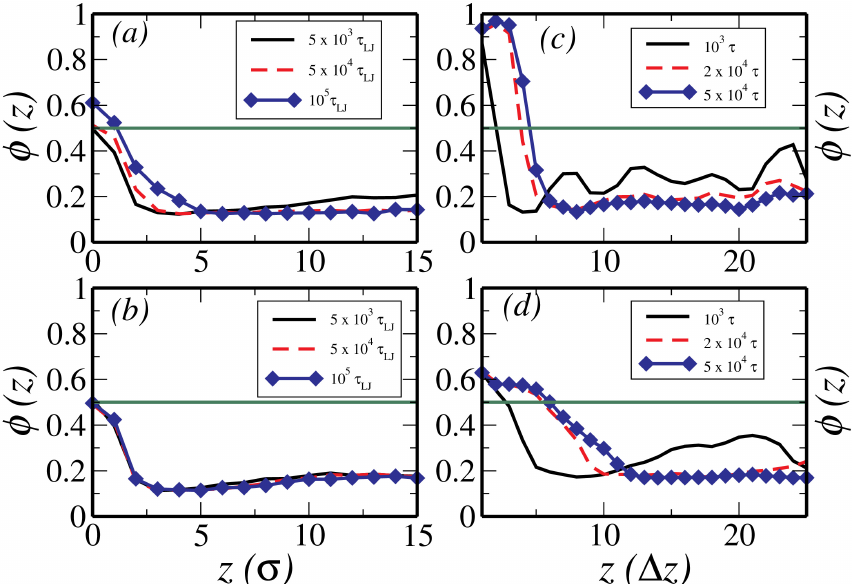
Figure 4. The time-evolution of the oligomer density computed from MD simulation in a polymer–oligomer system ( a ) and a gel–oligomer system ( b ) following a quench from an initial temperature of T i = 10 to a final temperature of T f = 1; ( c , d ) show the time evolution of the oligomer density computed from meso-scale simulations, following a quench to the two-phase region, for a polymer–oligomer and a gel–oligomer mixtures, respectively.